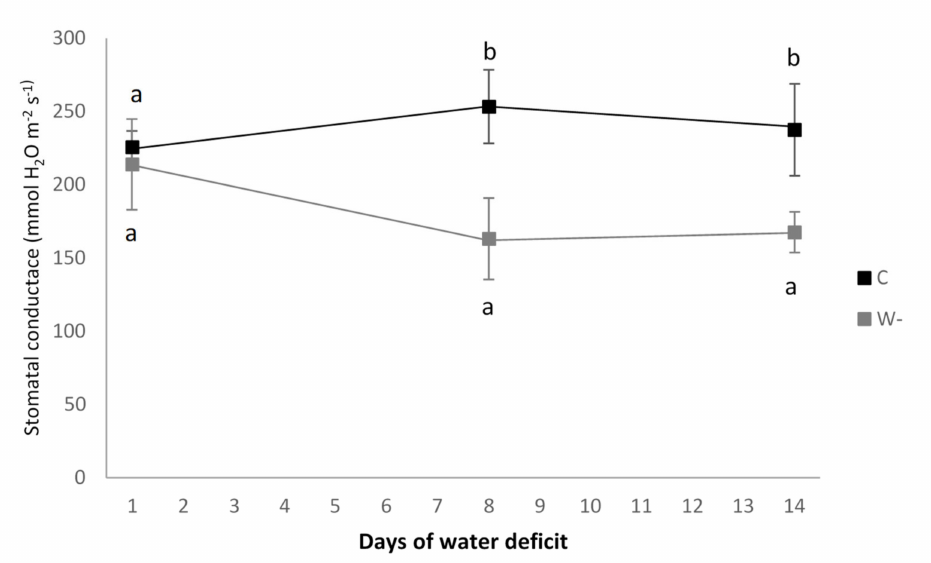
Figure 3. Stomatal conductance of the leaves for the control (C) and water shortage (W-) treatments of the buckwheat plants. Data are means ± standard deviation ( n = 7). Di ff erent letters indicate significant di ff erences in stomatal conductance between treatments within each sampling day ( p ≤ 0.05; t